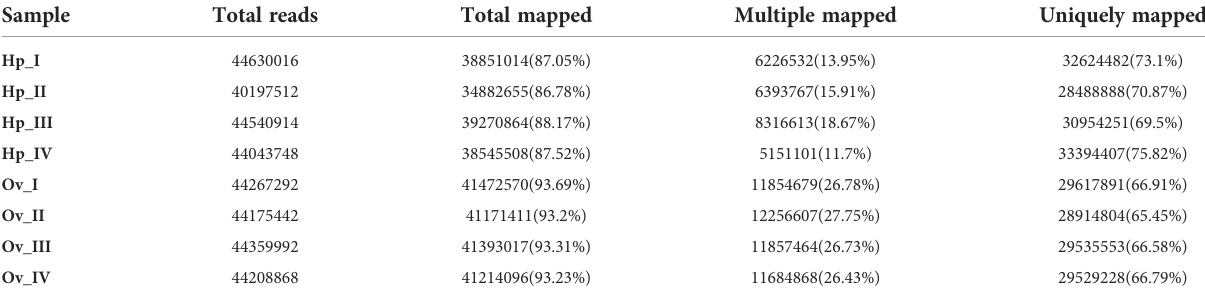
TABLE 4 Sequence Mapping Analysis.